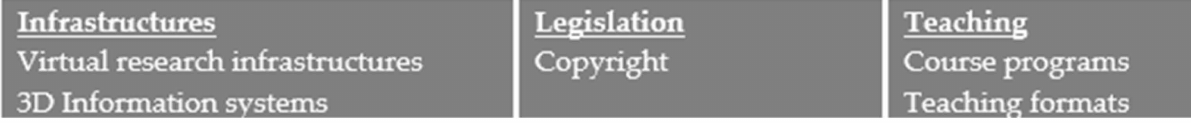
Figure 17. Chapter